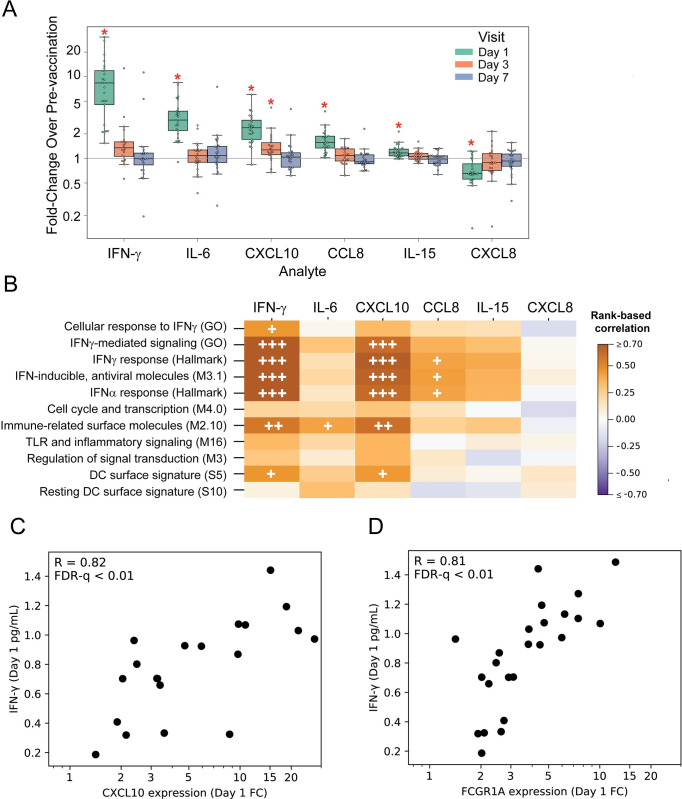
ALVAC-HIV vaccination rapidly induces alterations in serum cytokines and chemokines that are temporally associated with several PBMC gene expression modules (n = 24).A) Fold-change serum soluble factors after vaccination. Boxes extend through the interquartile range (IQR), with whiskers extending to the lowest and highest points within 1.5 times the IQR. Asterisks denote significant fold-changes in concentration relative to baseline (FWER-p<0.05, Wilcoxon signed-rank test). B) Correlations between fold-change in gene expression at Day 1 for each GSEA gene module with significant Day 1 fold-change in serum factor concentration. FDR-q: <0.2 (+), <0.1 (++), or <0.01 (+++). C, D) Scatterplots of Day 1 fold-change in expression of 2 example genes vs. serum IFN-γ concentrations. Each dot represents a single participant; R values represent the strength of the rank-based correlations.